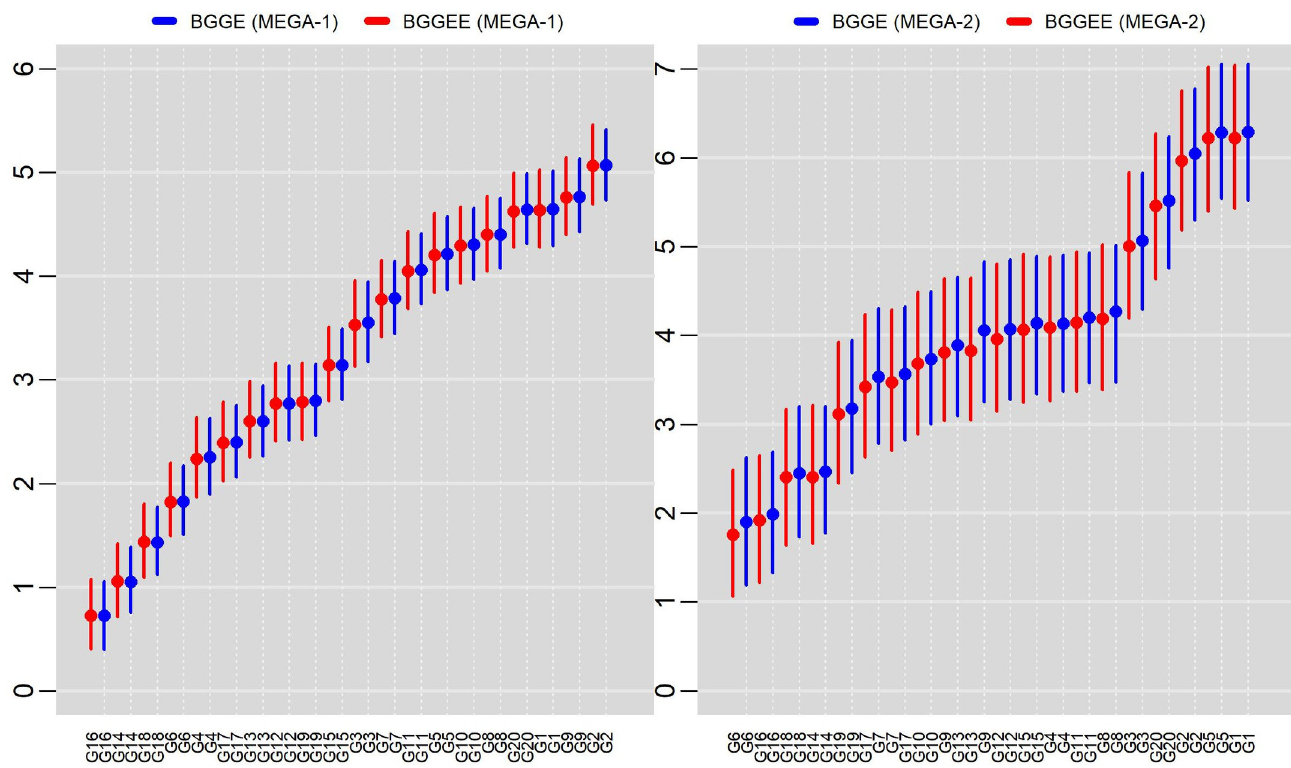
Fig 6. Mean scores and 95% HPD credibility intervals for distances of the genotypes to the ideal genotype in each mega-environment using the BGGE (Bayesian-GGE) and BGGEE (Bayesian-GGE entropy) models.